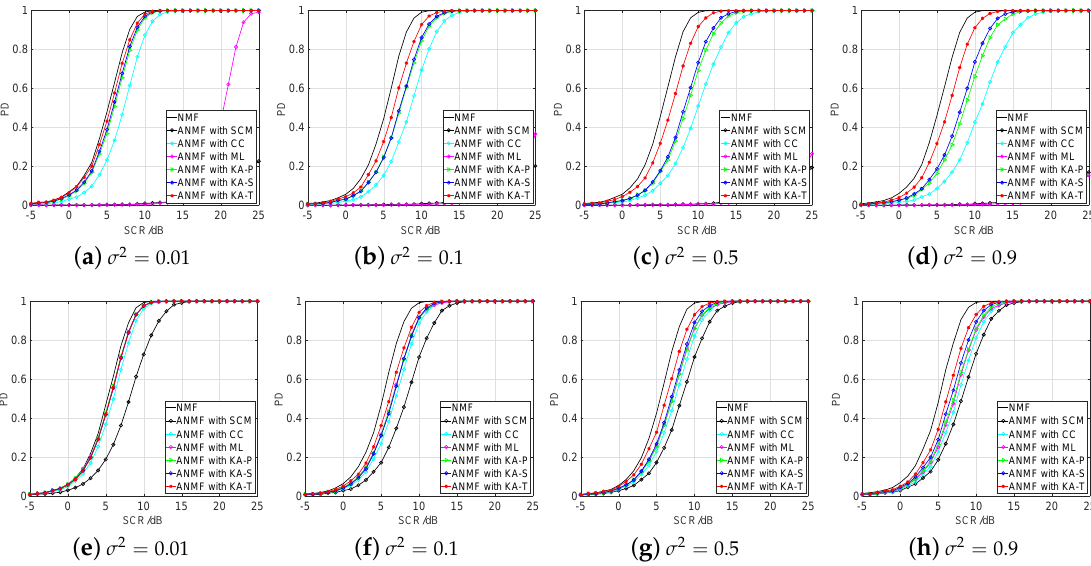
Figure 4. PD versa SCR with different values of the perturbation level in Gaussian clutter PFA = 10 − 3 , ( a – d ) K = 1 N ; ( e – h ) K = 2 N